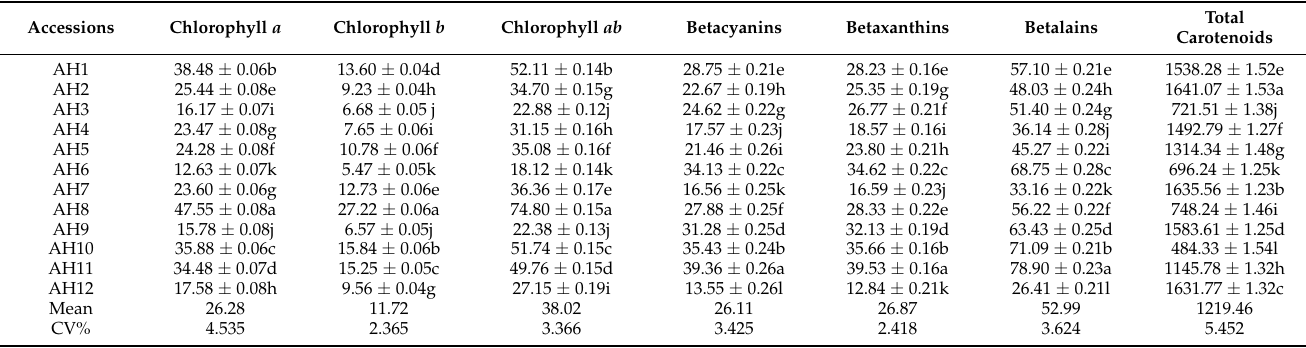
Table 3. The performance of phytopigments in 12 slim amaranth